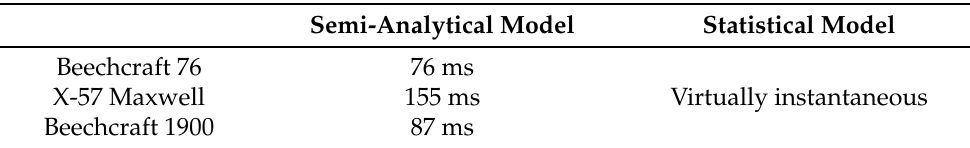
Table 6. Comparison of the computational time between the newly developed methodology and statistical